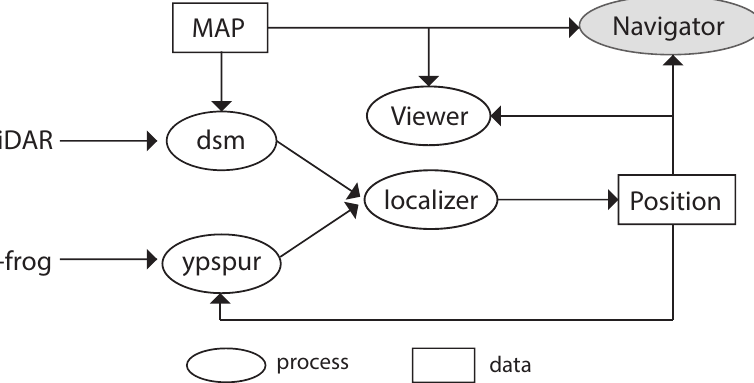
Figure 7. An overview of the autonomous robot